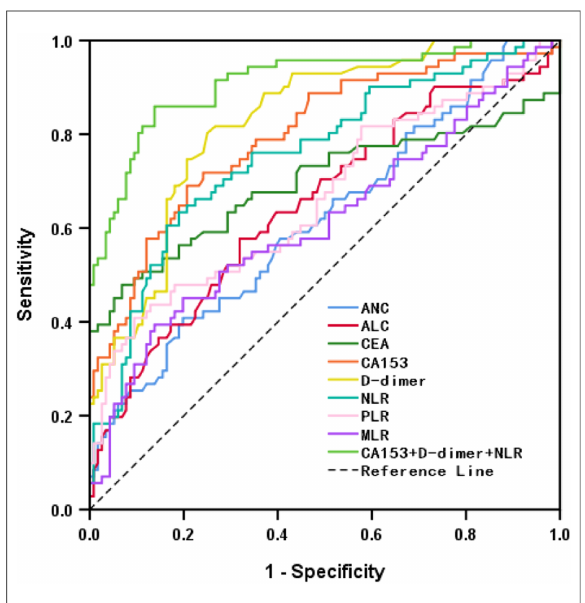
FIGURE 1 ROC of hematological indicators for diagnosing recurrence and metastasis of breast